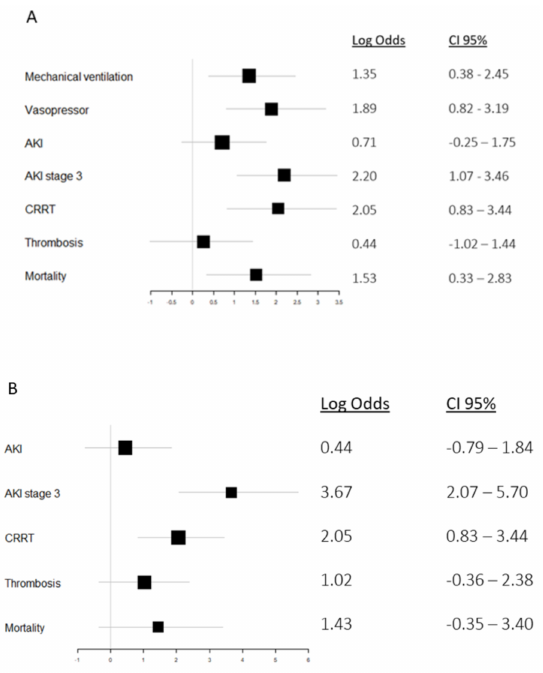
Figure 4. Log odds for outcomes dependent on the concentration of dimeric human neutrophil lipocalin in plasma at admission ( A ) and peak concentration of human neutrophil lipocalin in whole blood ( B ) during intensive care. For each outcome, a logistic regression was performed for P-HNL Dimer at admission and peak B-HNL during intensive care. The biomarker was used as a categorical variable, either above or below the cutoff of 13.2 µ g/L and 190 µ g/L, respectively, and the regression was adjusted for age. Patients with P-HNL Dimer and peak B-HNL concentrations above said cutoffs demonstrated increased risks of developing AKI stage 3 (8.99 and 39.2 respectively) and renal replacement therapy (7.77 for